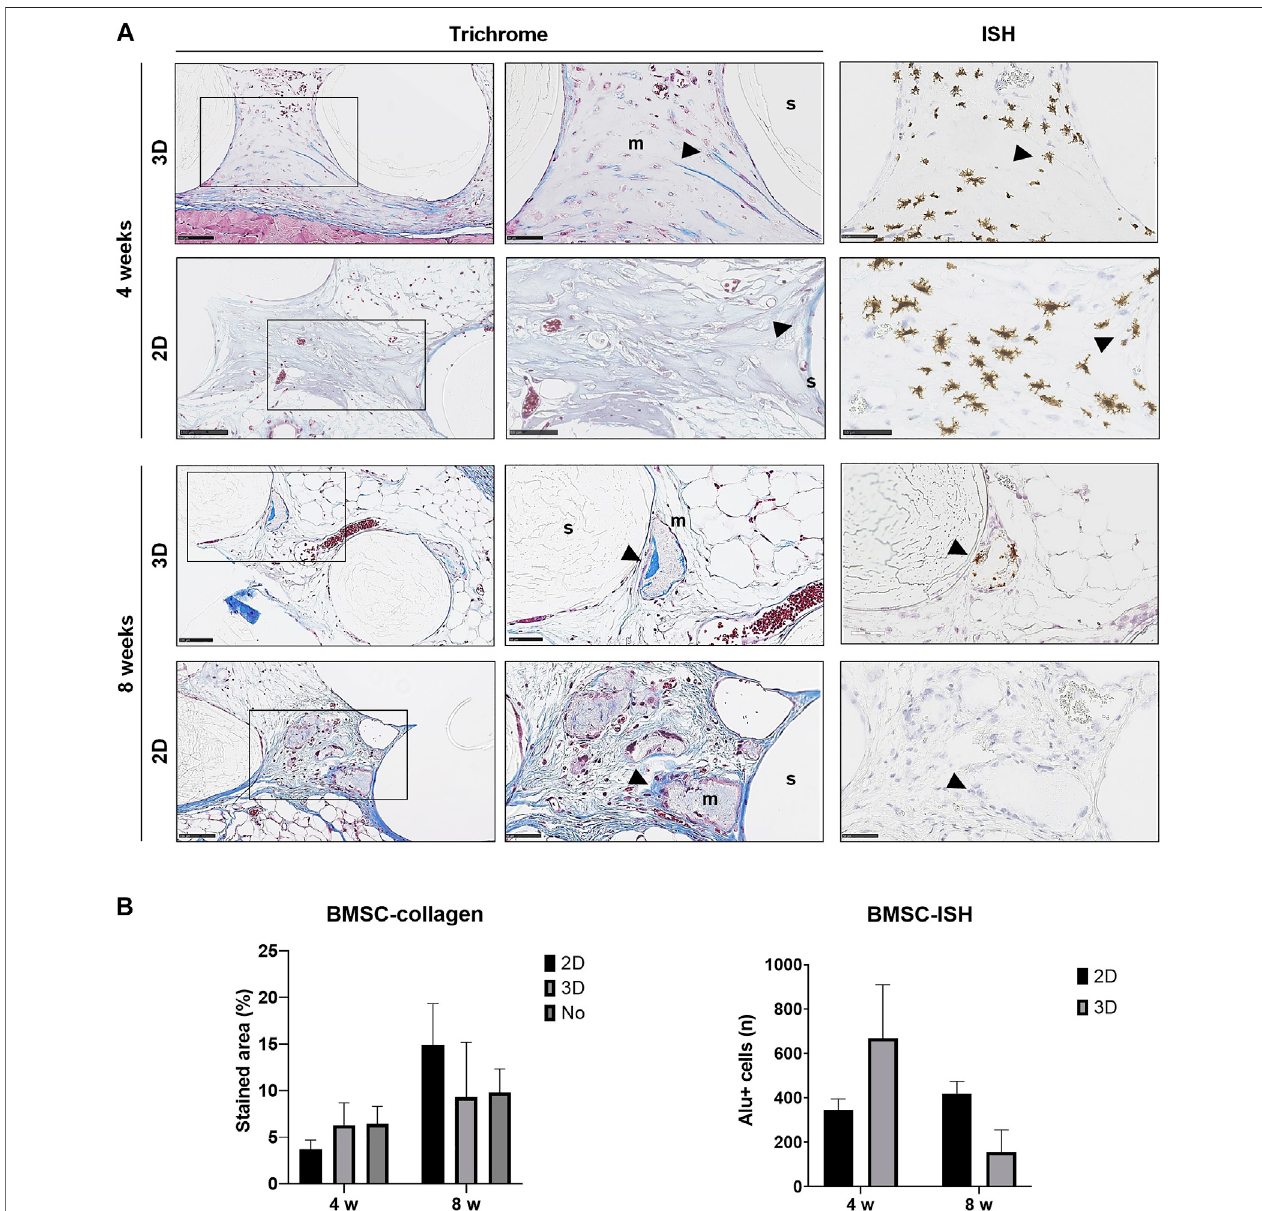
FIGURE4| HistologyofBMSC constructs. (A) Representativeimages ofTrichromeand corresponding ISH stainedsections of2D and 3DBMSC constructs after 4and8 weeks;m,mineralization;s,scaffold;wb,wovenbone;arrowsindicatedensecollagen(Trichrome)andAlu+cells(ISH) — exceptintheISHsectionof2D-GPCat 8 weeks where dense collagen does not correlate with Alu + cells in ISH; scale bars 100 μ m. (B) Quanti fi cation of collagen staining (Trichrome) and Alu + cells (ISH); n , total number; data represent means ± SD ( n (cid:1) 3).